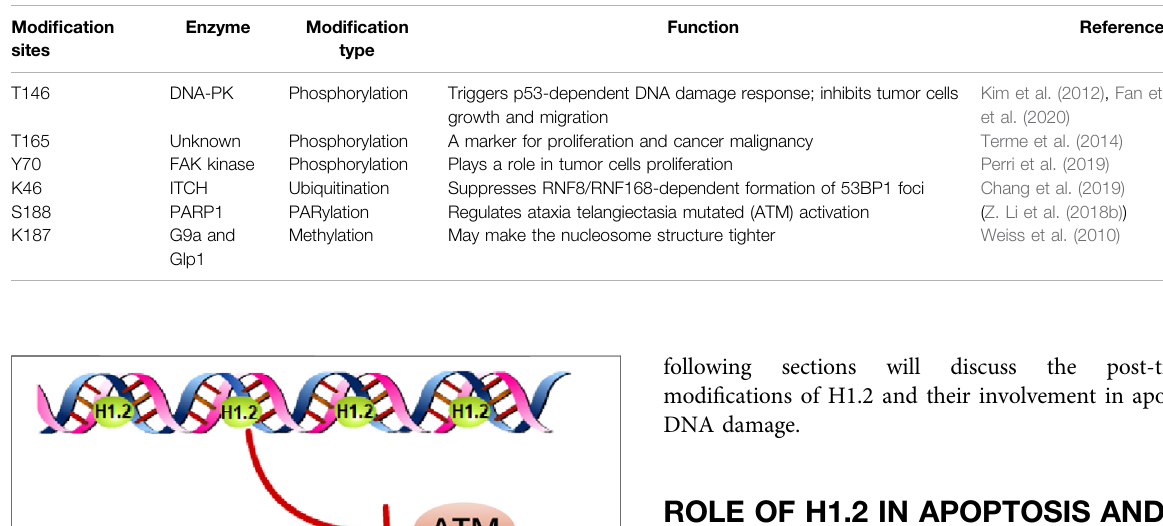
TABLE 1 | The modi fi cation sites and function of H1.2.